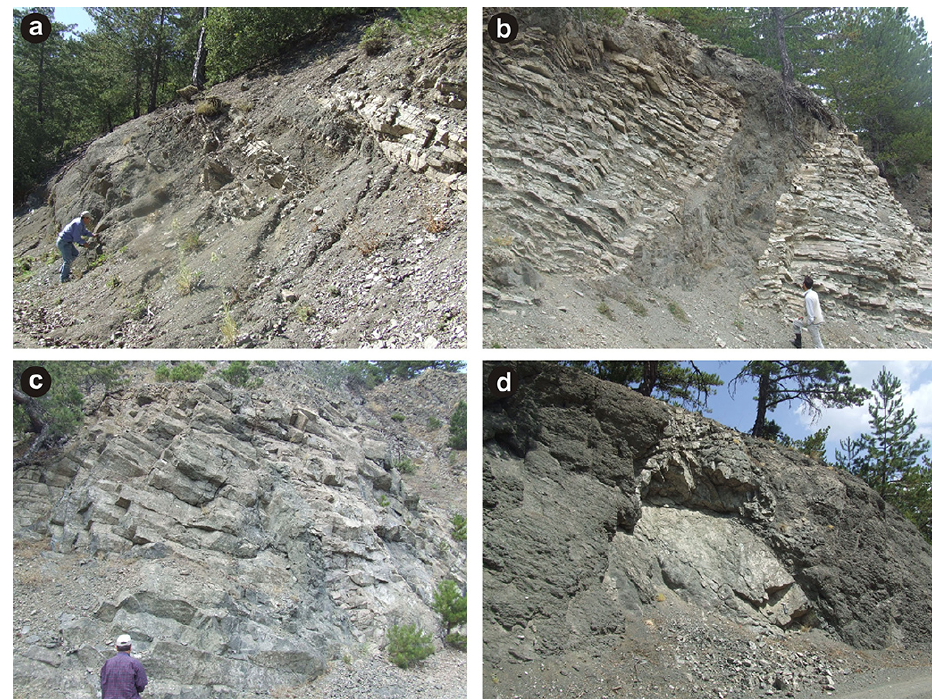
Fig. 9. (a) Limestone–volcanic sandstone intercalation in the island arc sequence. (b) A mafic dike (island arc origin) crosscutting the pelagic limestone rocks. (c) Alkaline basaltic rocks with columnar joint structures. (d) Arc volcaniclastic rocks intruded by basaltic to andesitic dikes.